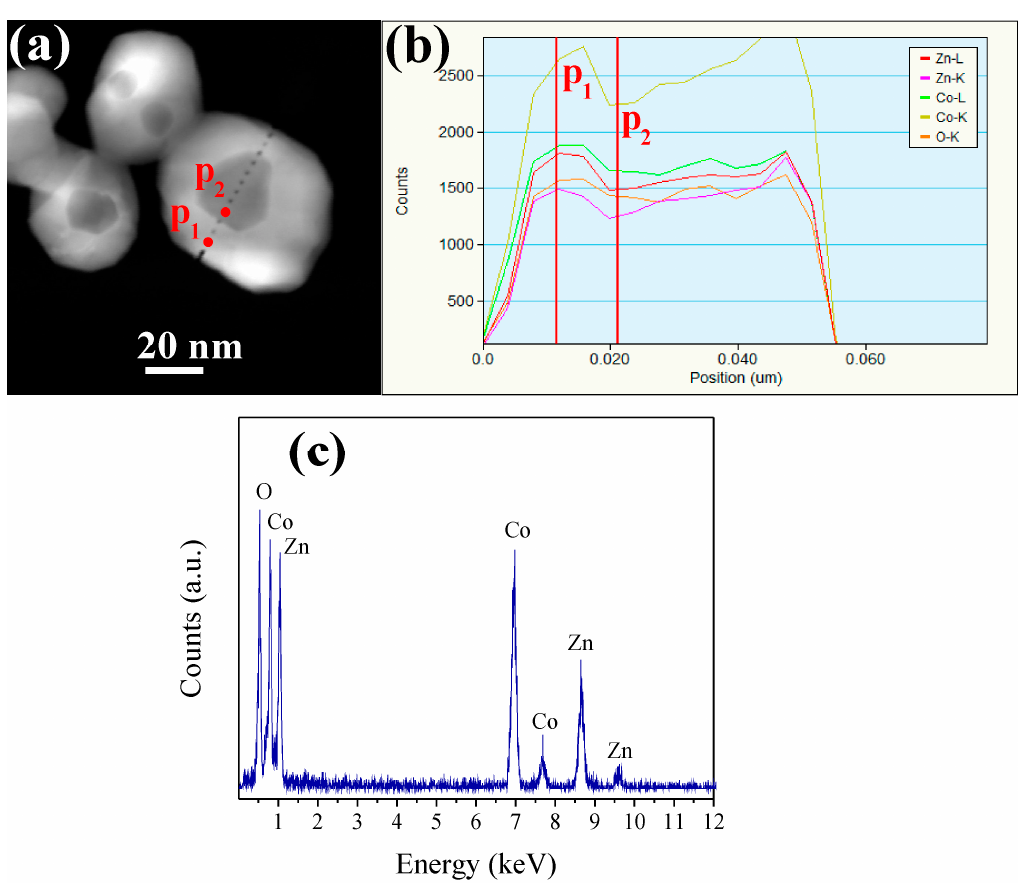
Figure 7. ( a ) HAADF-STEM image; ( b ) elemental line scan; and ( c ) EDS microanalysis of sample A.